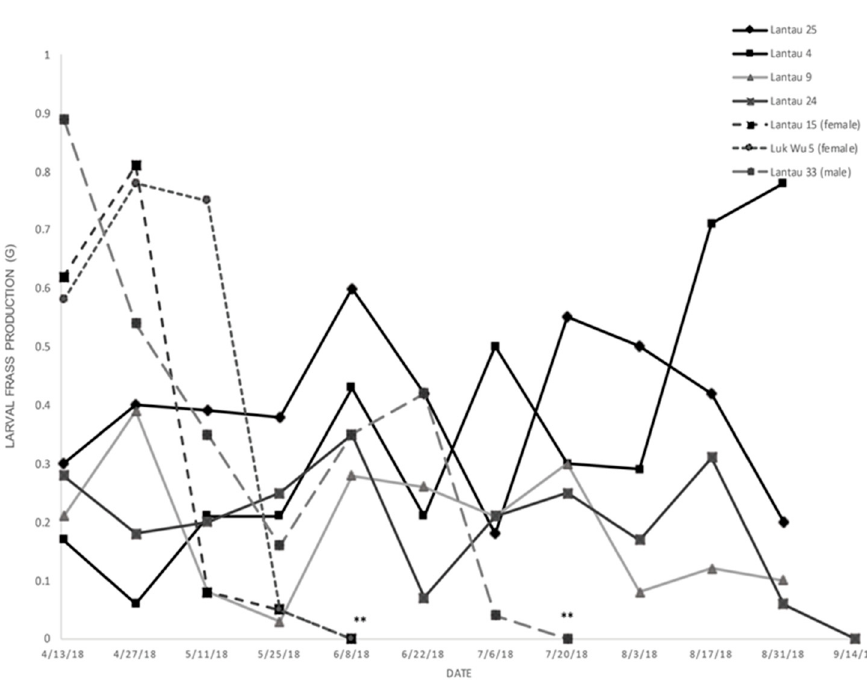
Figure 11. Bi-weekly frass production (dried g) of C. subagronoma larvae. Dashed lines are from late-instar larvae (**) that pupated (signaled by quiescence of frass